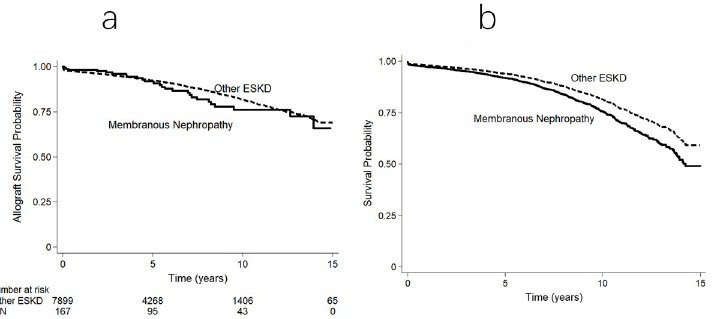
Fig 3. Overall first kidney allograft survival curves for patients undergoing kidney transplantation for ESKD in Australia and New Zealand. (a) Unadjusted Kaplan–Meier survival curve. (b) Survival curve adjusted for demographic, comorbidity and allograft indices. The difference between the groups was not significant (unadjusted p = 0.53; adjusted p =